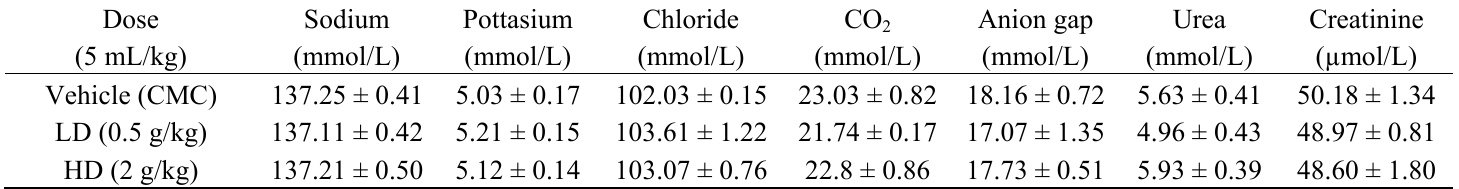
Table 1. Renal function test of rats in acute toxicity study of P. jiringa extract.